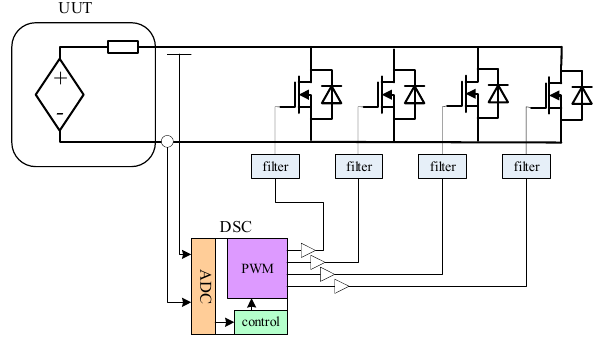
Figure 2. System Figure 2. System structure.